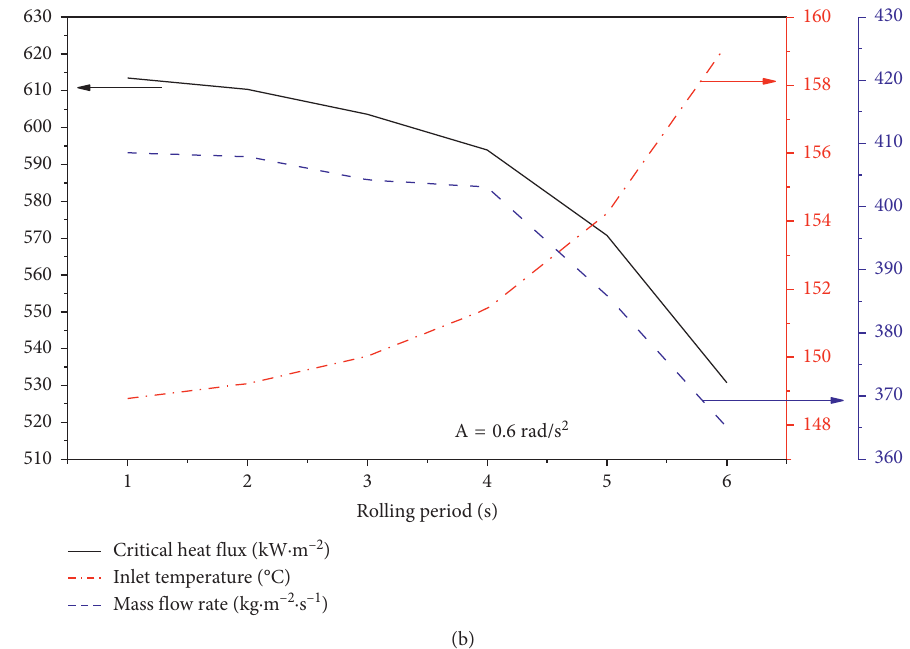
Figure 16: Influence of rolling period on CHF. (a) A � 0.1rad/s 2 . (b) A � 0.6rad/s 2